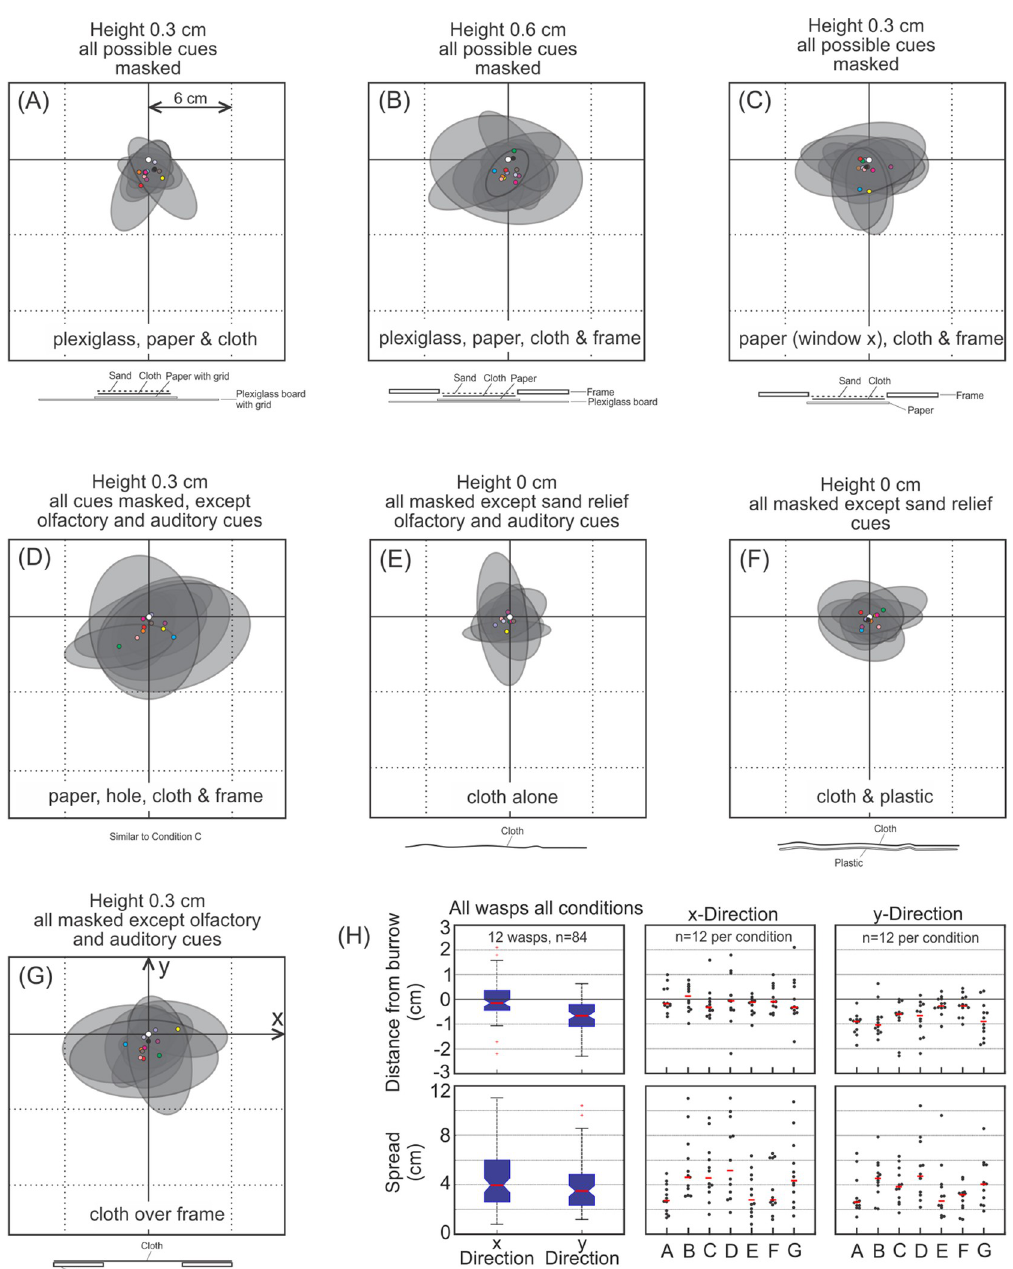
Fig 6. Investigating local burrow location cues II. The distribution of 15 digging attempts (see Fig 2R) of each of 12 wasps returning to their locally altered burrow environment. Grey ellipses are ellipses of equal probability covering 99% of the digging attempts of each wasp. Coloured dots mark the means of these distributions. Burrow entrance marked with a white circle at the intersection of x- and y-axes as labeled in G. (A)—(G) Show the distributions for the 7 experimental conditions. (H) Left column panels show boxplots of x- and y-distances (top) and spread in x- and y-direction (bottom) from true burrow location across all conditions. Medians are indicated by horizontal red lines, box size shows 25th and 75th percentiles, whiskers extend to the most extreme data points not considered outliers and outliers (points more than 1.5 times the interquartile range away from the top or bottom of the box) marked by red crosses. Middle and right column panels show for each condition separately the individual means in x- and y-direction (top row) and ellipse extent or spread in x- and y- direction (bottom row). Medians are marked by horizontal red lines. See text for statistical